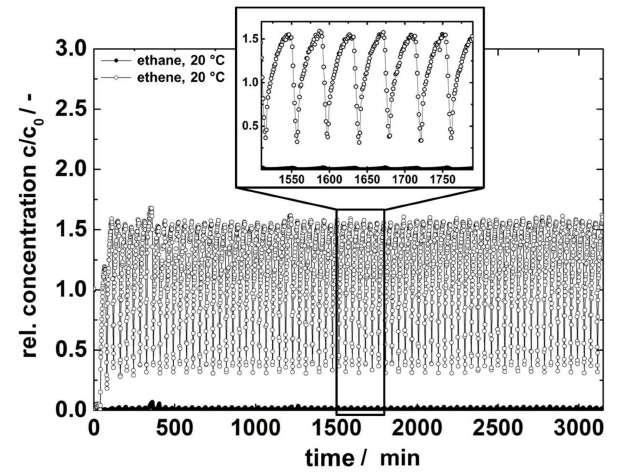
Figure 4. Continuous separation of an equimolar ethane/ethene mixture at ambient pressure and 20 ◦